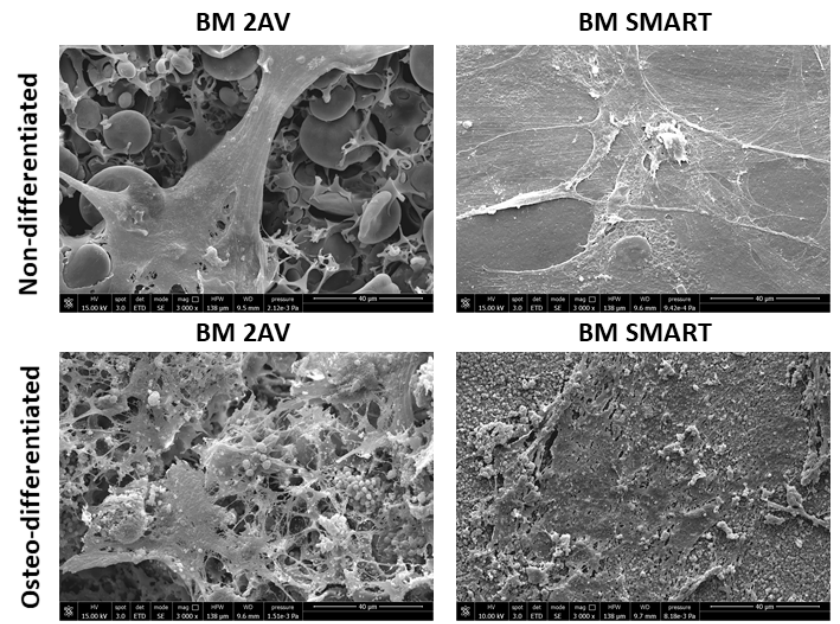
Figure 8. SEM micrographs of BM 2AV and BM SMART films cultured with hMSCs under basal (undifferentiated) and osteodifferentiated conditions.